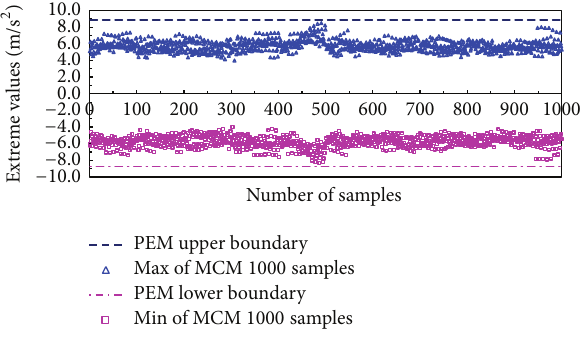
Figure 10: Comparison of vertical acceleration of trailer carbody.